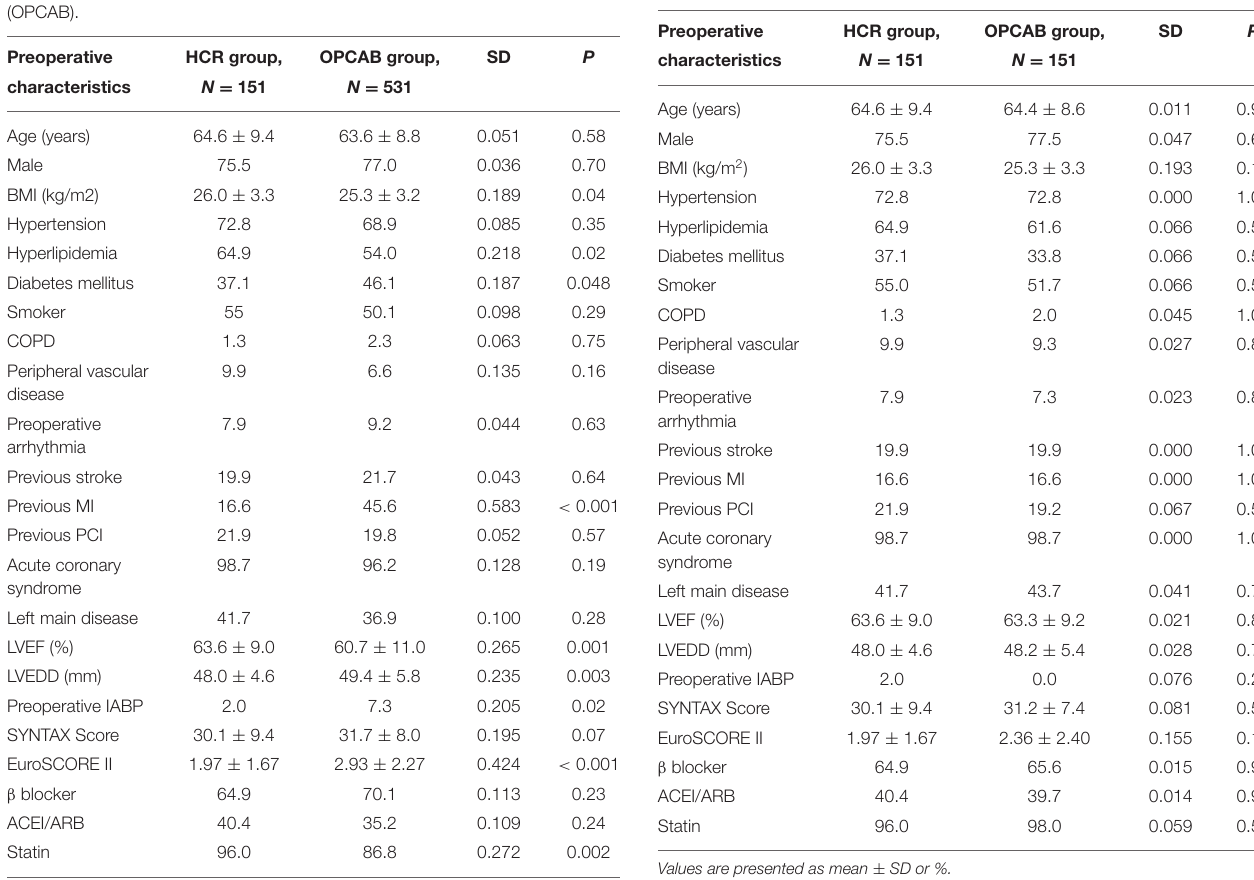
TABLE 2 | Preoperative characteristics of matched patients who underwent HCR and OPCAB.